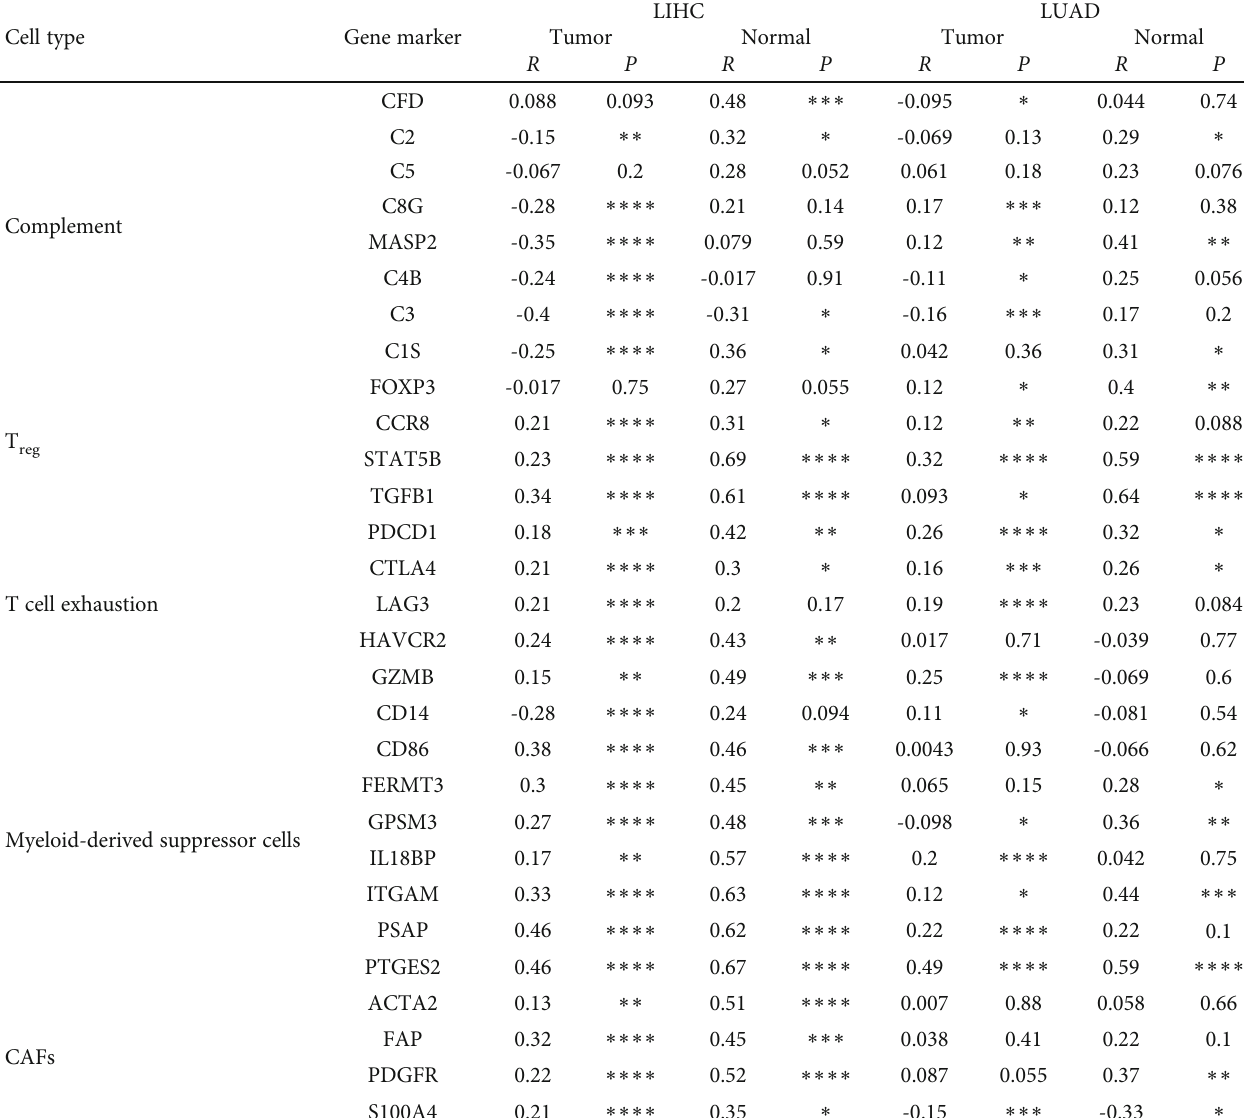
, T cell exhaustion, and myeloid-derived suppressor cells. regs